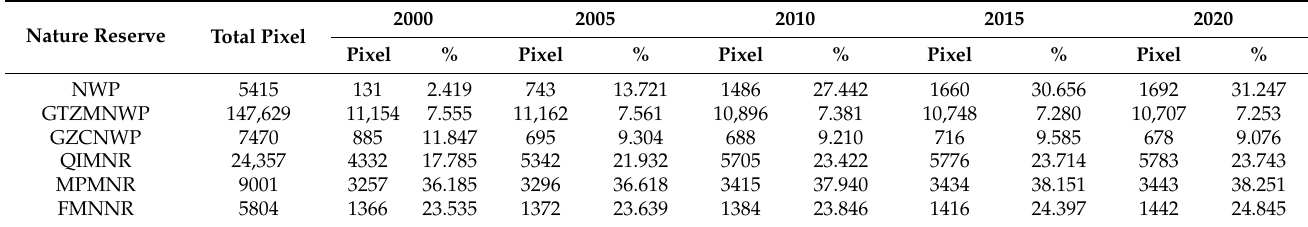
Table 4. Mangrove proportion of total pixels in nature reserves.